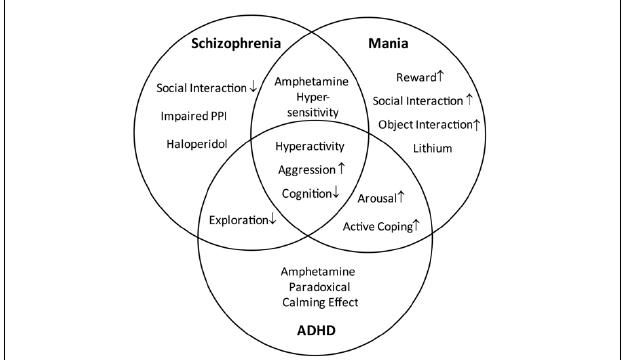
FIGURE 2 | Assignment of different behavioral tests to the endophenotypic symptoms of schizophrenia, mania, and ADHD. Each diagram highlights the behavioral traits evaluated by the corresponding test(s) (face validity). OF, open field; HB, holeboard; PPI, prepulse inhibition; TST, tail suspension test; ASR, acoustic startle response; WCM, water